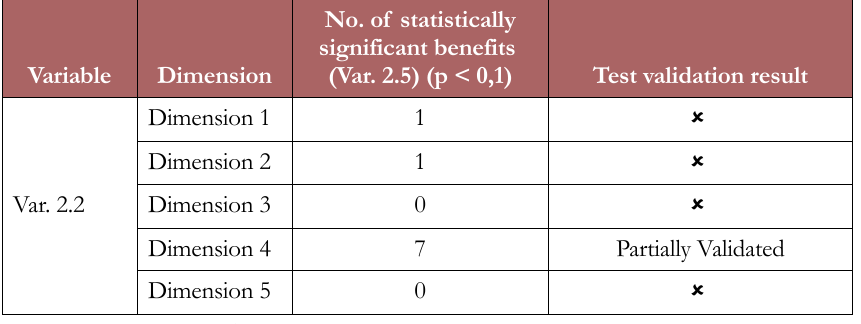
Table 4. Hypothesis 9